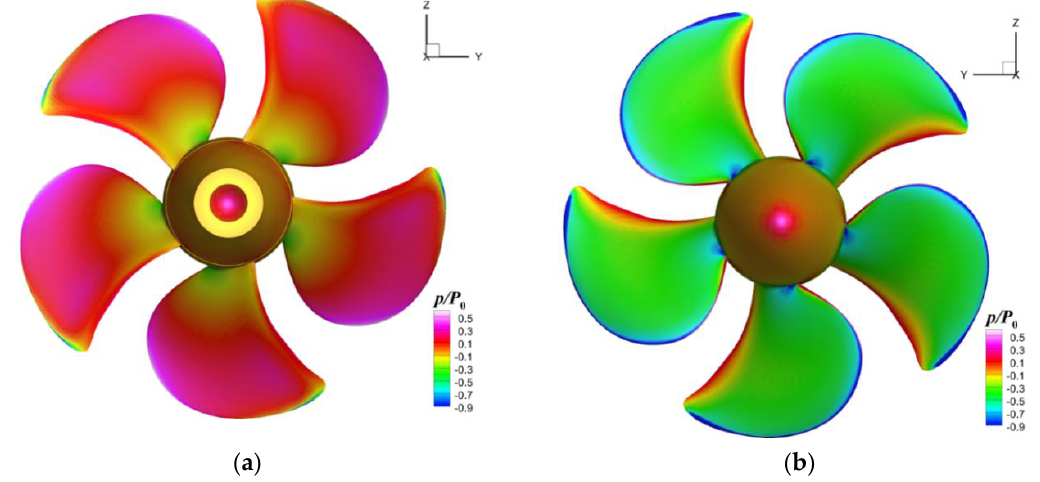
Figure 4. Propeller performance diagrams. Comparison between the numerical solutions and experimental data provided in [36].